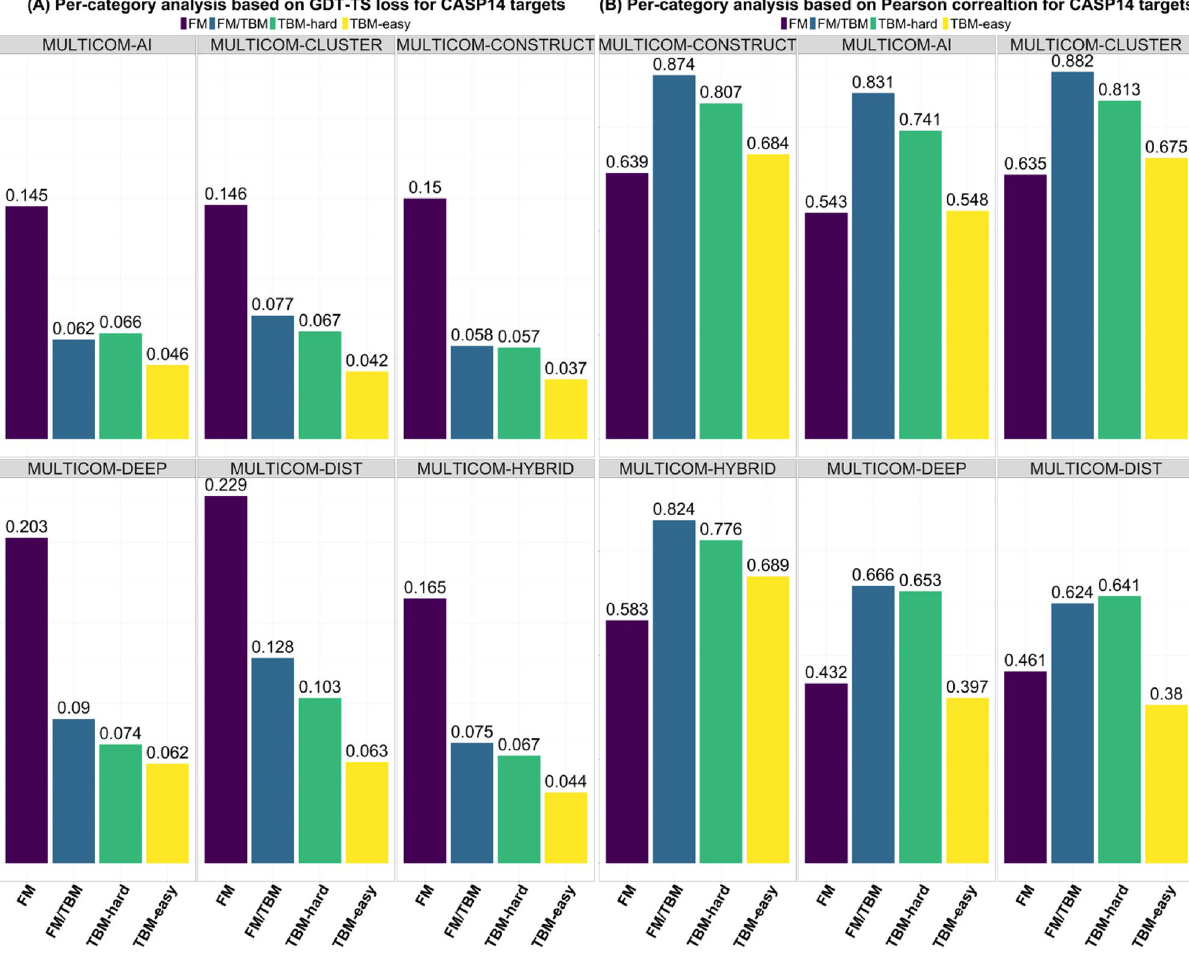
Figure 4. The performance of MULTICOM EMA predictors on four different categories of targets (FM, FM/ TBM, TBM-hard, and TBM-easy). ( A ) GDT-TS ranking loss. ( B ) Pearson’s